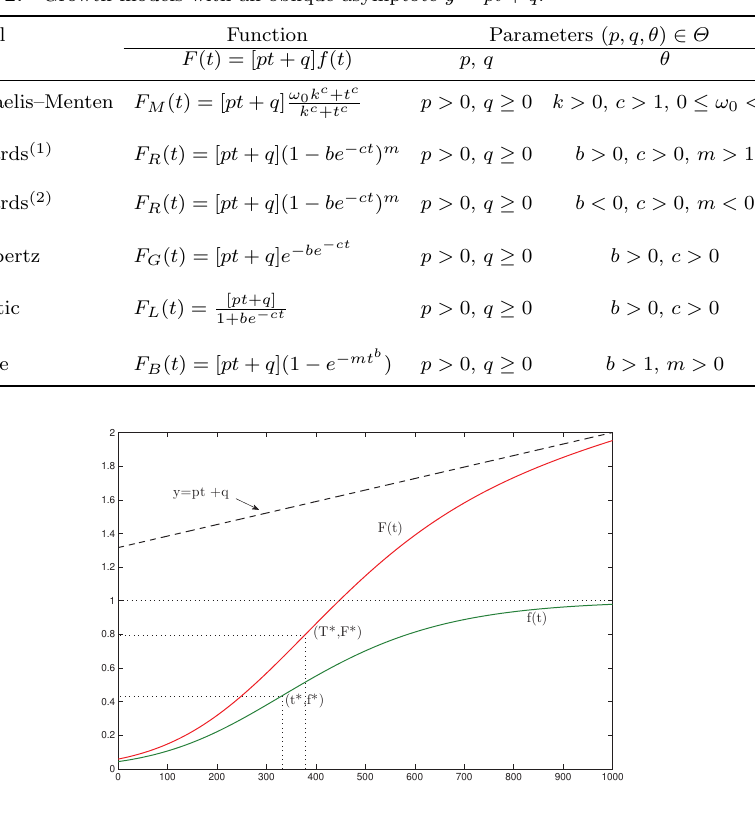
Figure 1. Graphic representation of a growth model f ( t ) and its modified model F ( t ) with their respective asymptotes y = 1 and y = pt + q and inflection points ( t ∗ ,f ∗ ) and ( T ∗ ,F ∗